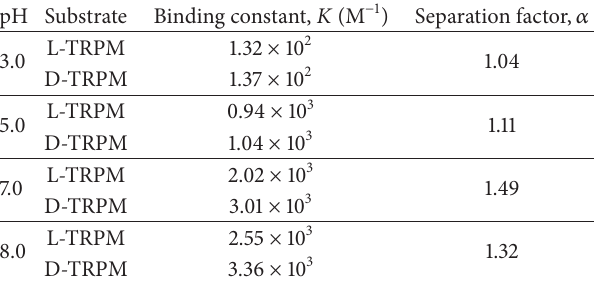
Table 2: The adsorption of L-TRPM and D-TRPM on the D-TRPM- imprinted polymer.